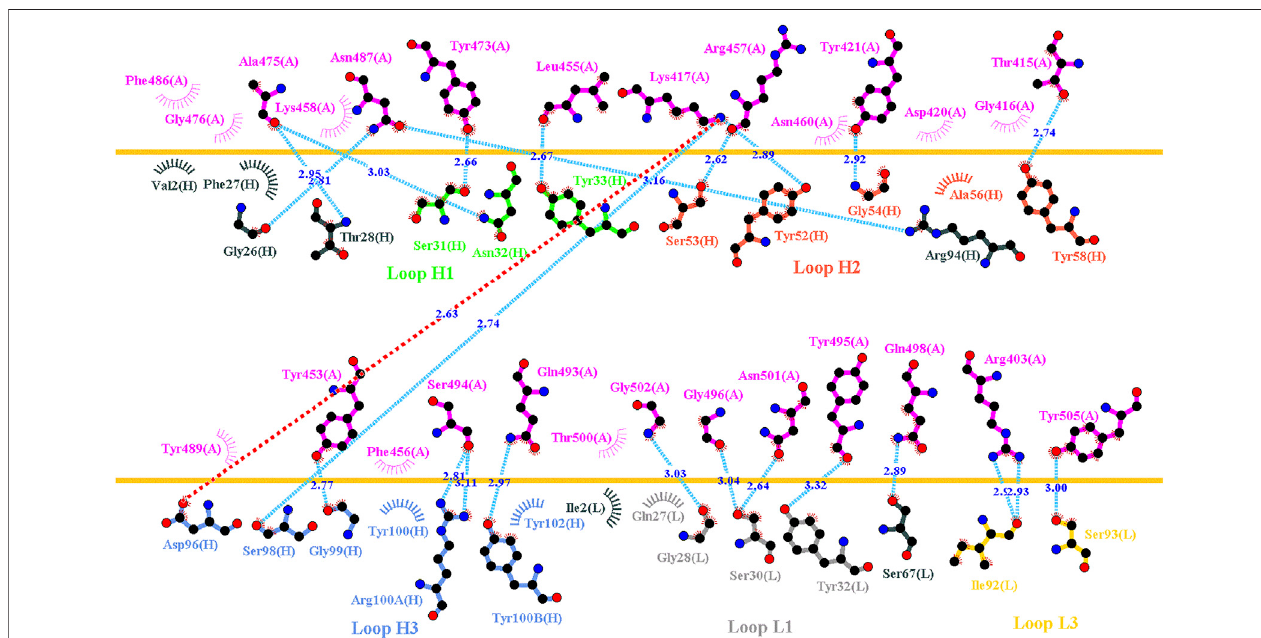
FIGURE 6 | Interactional network of the RBD and CA1-B12 antibody analyzed using LIGPLOT. LIGPLOT was employed to examine the interaction network of the SARS-CoV-2RBDandCA1-B12.TheRBDandlightandheavychainsofCA1-B12werelabeledA,H,andL,respectively.Thegoldenyellowlinedenotestheinterfaceof the RBD – CA1-B12 complex. Theinteractive residues oftheRBDarelabeledandcoloredmagenta. Thesalt-bridges, hydrogen bonds andhydrophobicinteractionsare represented by red, cyan dashes and arcs with spokes radiating toward the ligand atoms with which they are contact,